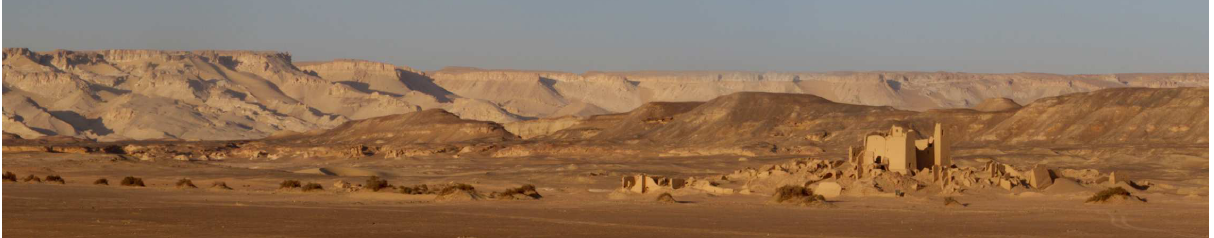
Figure 1. Panorama of Umm el Dabadib (Photo by Fassi